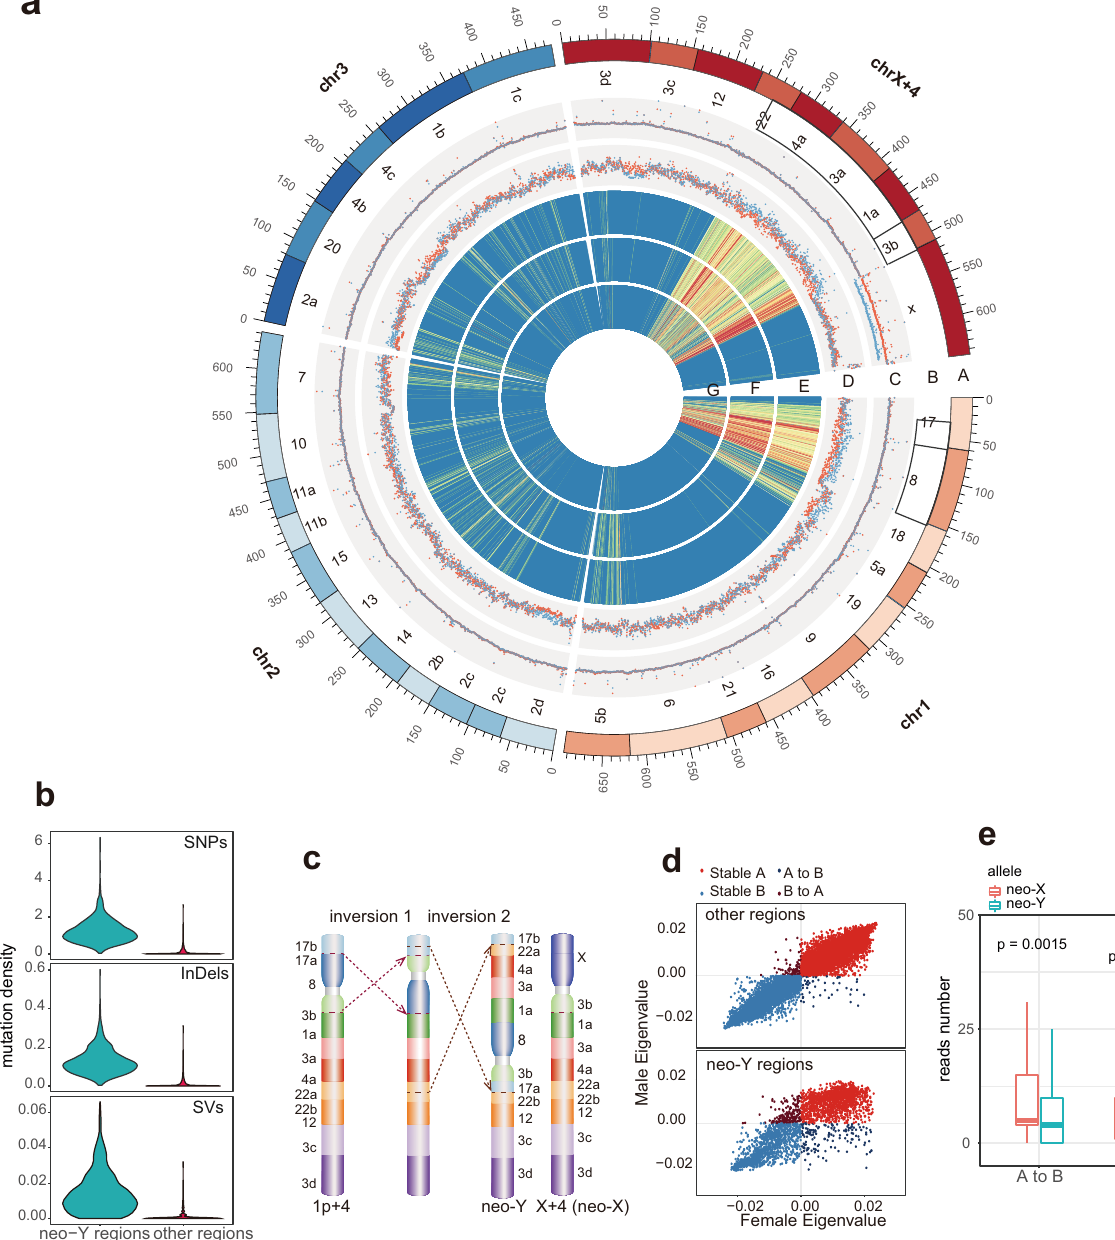
Fig. 4 Evolution of neo-sex chromosomes in M. crinifrons . a Circos plot of female M. crinifrons genome. Track A: chromosomes of female M. crinifrons showed by 35 colored ancestral chromosomes. Track B: labels of ancestral chromosome under previous nomenclature 21 . Black frames enclose neo-X regions. Track C: Mapping coverage of female (red) and male (blue) M. crinifrons Illumina reads. Track D: SNPs and indels density of female (red) and male (blue) M. crinifrons . Track E: Heatmap showing the density of candidate male-speci fi c SNPs. Density from low to high correspond the color group “ spectral- 7-div-rev ” in circos. Track F: Heatmap showing the density of candidate male-speci fi c indels with the same colors coding as track E. Track G: Heatmap showing the density of candidate male-speci fi c SVs with the same colors coding as track E. b Violin plot showing the density of candidate male-speci fi c mutations in neo-Y regions and other regions. c Two inversion events happened on the neo-Y chromosome of male M. crinifrons . Block 17a, 17b, 22a, and 22b are ancestral chromosomal segments disrupted by inversions and each of the remaining colored blocks represent the completed ancestral chromosome. d The eigen values of homologous bins in female and male M. crinifrons . Eigen value greater and less than zero means compartment A and B, respectively. The “ other regions ” indicate genomic regions excluding neo-Y regions and mammalian X chromosome region. e Boxplot of number of RNA- seq reads supporting neo-X or neo-Y allele in male M. crinifrons sample. “ A to B ” means compartment switch from A in neo-X regions of female M. crinifrons to B in homologous neo-Y regions of male M. crinifrons . “ B to A ” is opposite. There are 160 pairs of neo-X and neo-Y alleles in “ A to B ” regions and 366 pairs in “ B to A ” regions. The lower and upper hinges correspond to the fi rst and third quartiles. The line inside box is the median. The whisker extends from the hinge to at most 1.5 * IQR (where IQR is distance between the fi rst and third quartiles). Outliers are hidden. Difference in reads number supporting neo- X and neo-Y alleles was tested by two-sided Wilcoxon test ( p value <0.05).